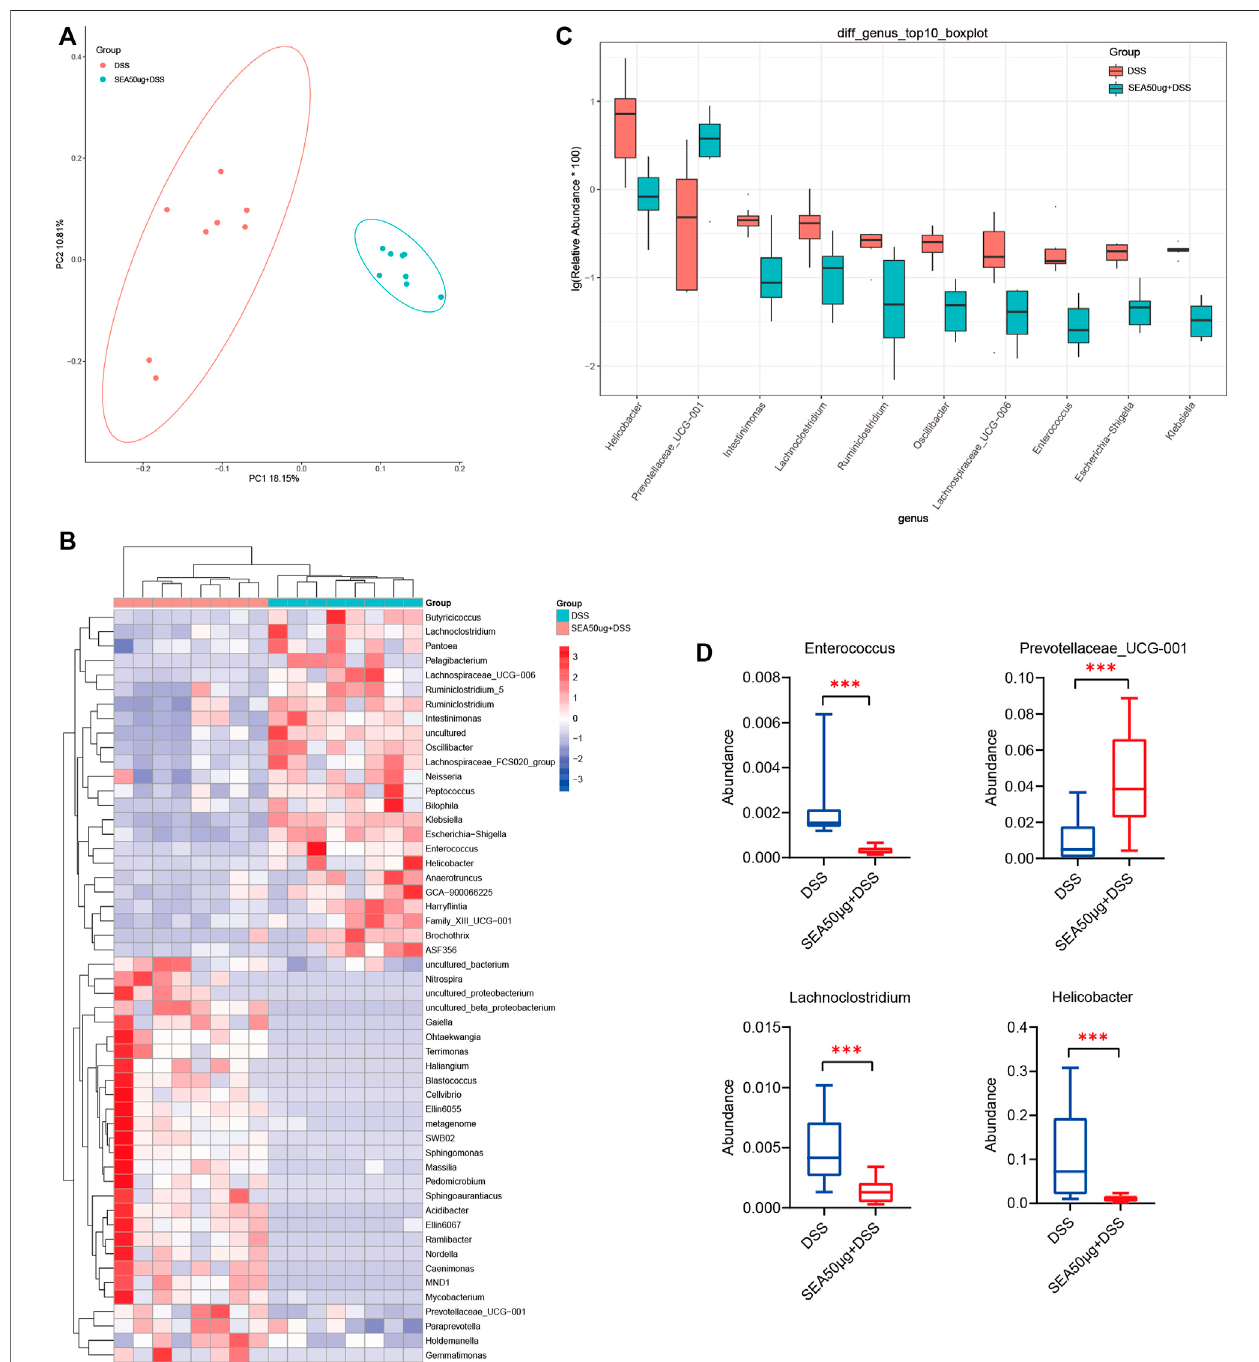
FIGURE 3 | Intestinal micro fl ora of mice with DSS-induced IBD mice treated with SEA. (A) Principal coordinate analysis (PCoA) of intestinal micro fl ora in the DSS andSEA50 μ g+DSSgroups(C50group).RedrepresentsDSSgroup,bluerepresentsSEA50 μ g+DSSgroup,andeachiconrepresentsagroupofsamples. (B) DSS and SEA 50 μ g + DSS group showed signi fi cantly differences after t test analysis. Comparative heat map (at the genus level). Each column represents a sample, and orangerepresentstheSEA50 μ g+DSSgroup. (C) Comparisonoftheabundanceofthe fi rst10speciesintheDSSandSEA50 μ g+DSSgroup(atthegenuslevel) (D) Comparison of the abundance of intestinal Helicobacter, Lachnoclostridium, Enterococcus, Prevotellaceae _UCG-001 in the DSS and SEA 50 μ g + DSS group (at the genus level).